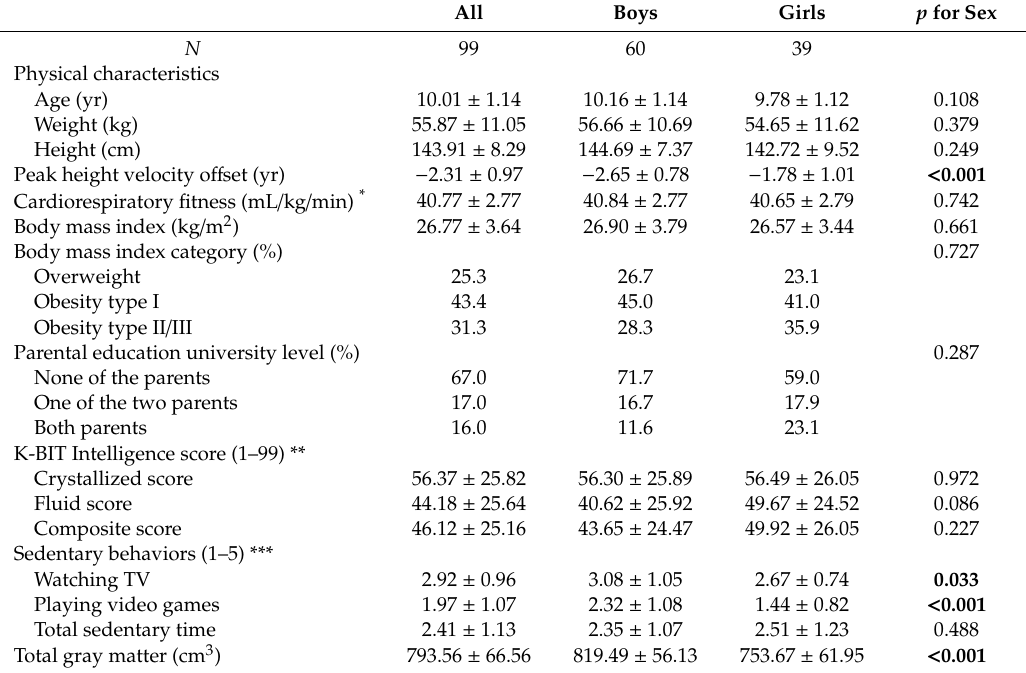
Table 1. Characteristics of the study